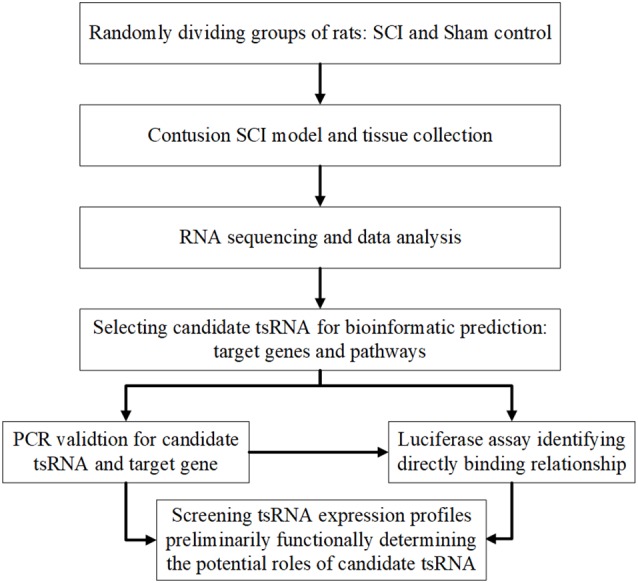
Study design illustration. SCI, spinal cord injury; FC, fold change; qRT-PCR, quantitative real-time polymerase chain reaction.